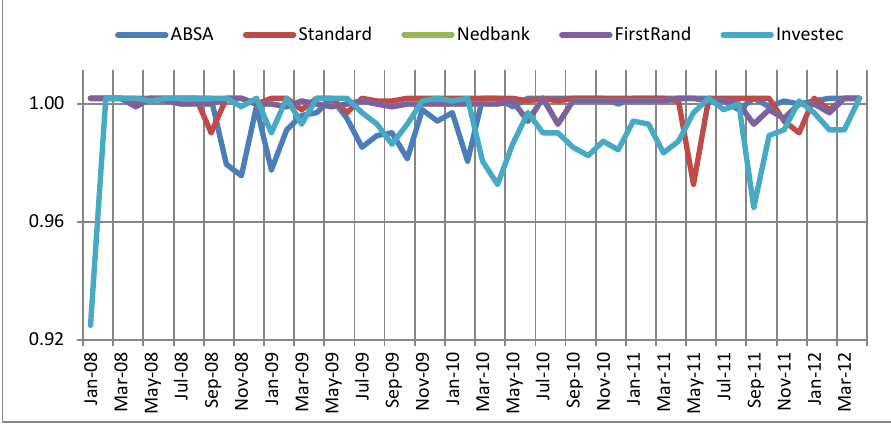
FIGURE 4: Comparison in terms of scale efficiency (input-orientated) Source: